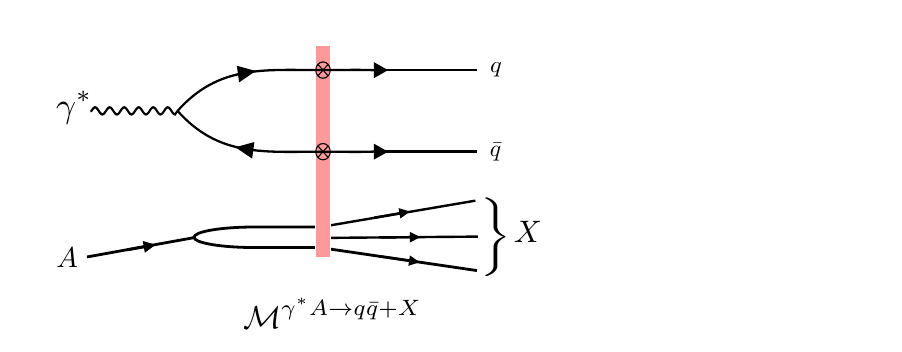
q ¯ q + X for the quark–anti-quark dijet production γ ∗ A → M